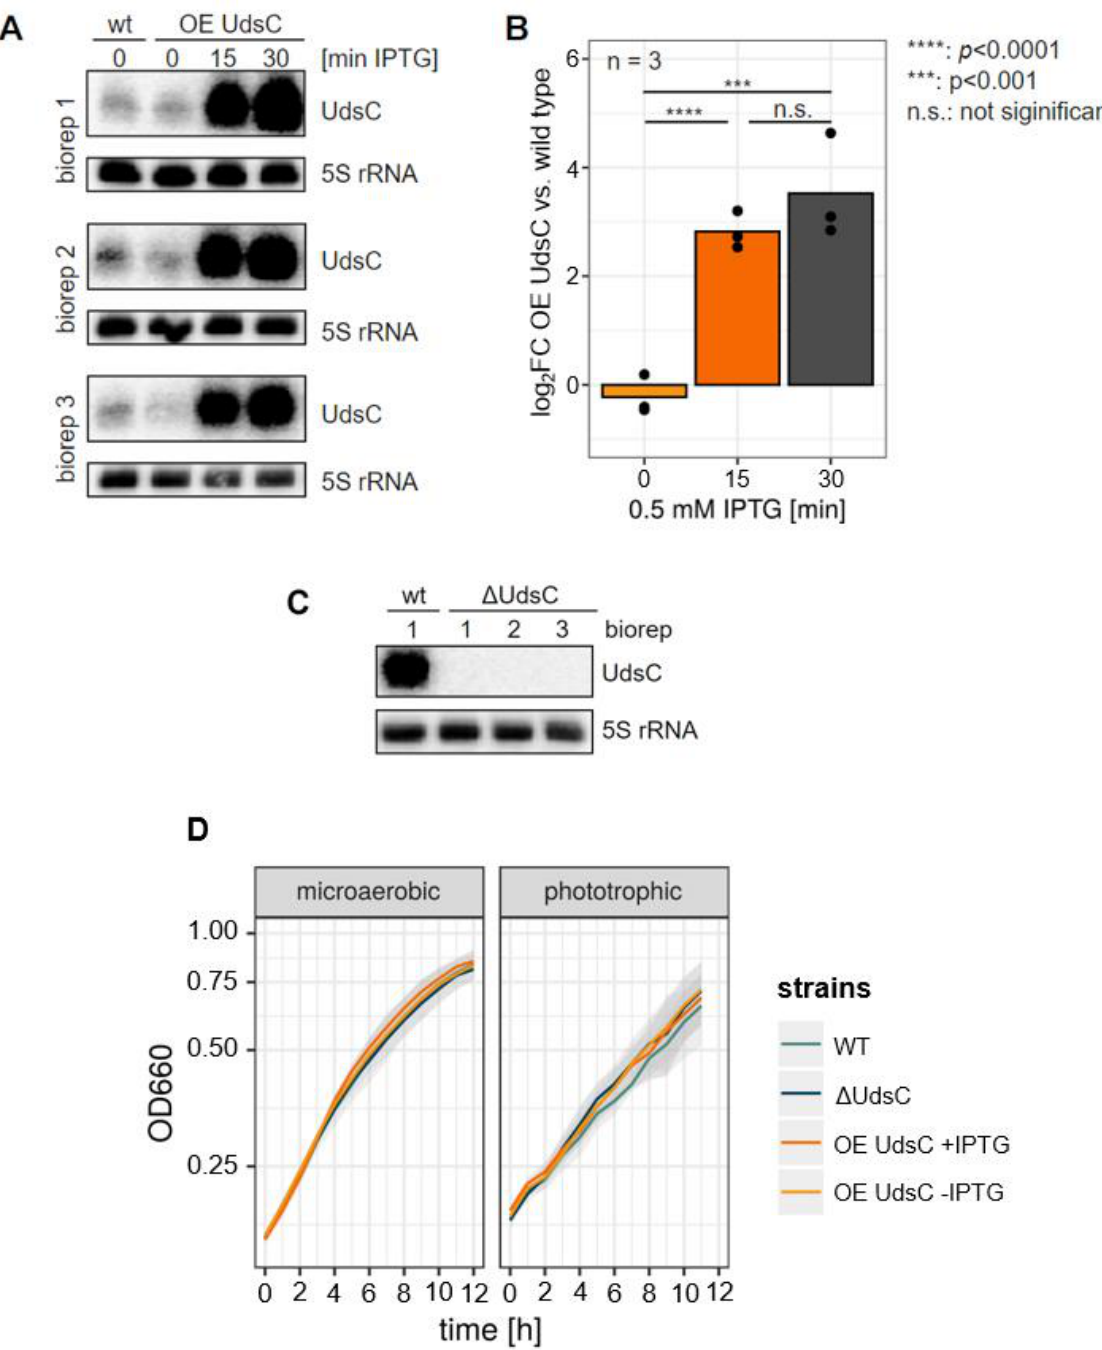
Figure 1. ( A ) Northern blots with total RNA (biological triplicates) from wild type (WT) or the UdsC-overexpression strain (OE UdsC) hybridized to an UdsC-specific probe (upper panels) or to 5S rRNA as loading control (lower panels). ( B ) The signals for UdsC were normalized to 5S rRNA and plotted for the different time points after IPTG addition. The bars represent the mean of the single measurements (dots), and the significance of the differences is indicated. ( C ) Northern blot from total RNA of the wild type (WT) and the strain deleted for UdsC ( Δ UdsC) (biological tripli- cates) hybridized against UdsC ( upper panel) or 5S rRNA ( lower panel). ( D ) Growth curves of WT,